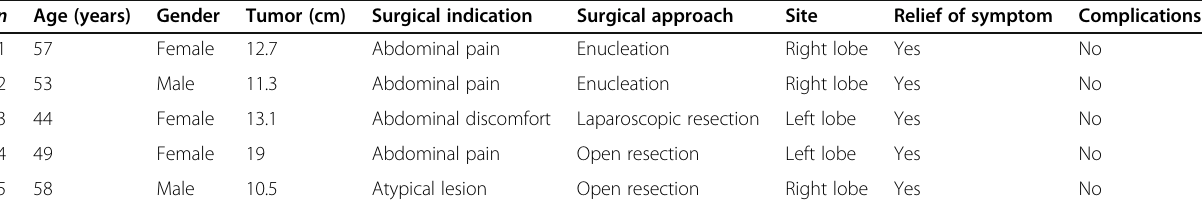
Table 2 Data of the five patients who underwent surgery for hepatic hemangioma n Age (years) Gender Tumor (cm) Surgical indication Surgical approach Site Relief of symptom